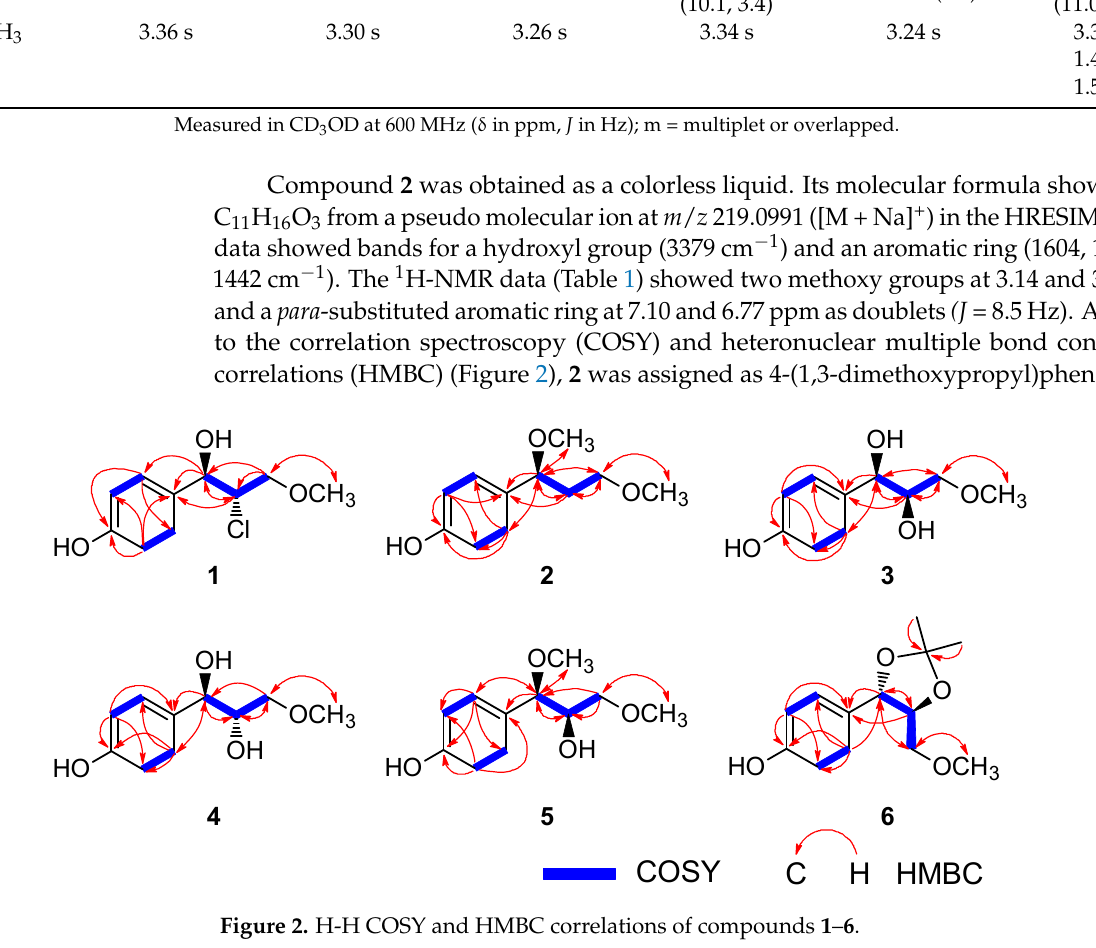
Figure 2. H-H COSY and HMBC correlations of compounds 1 – 6.